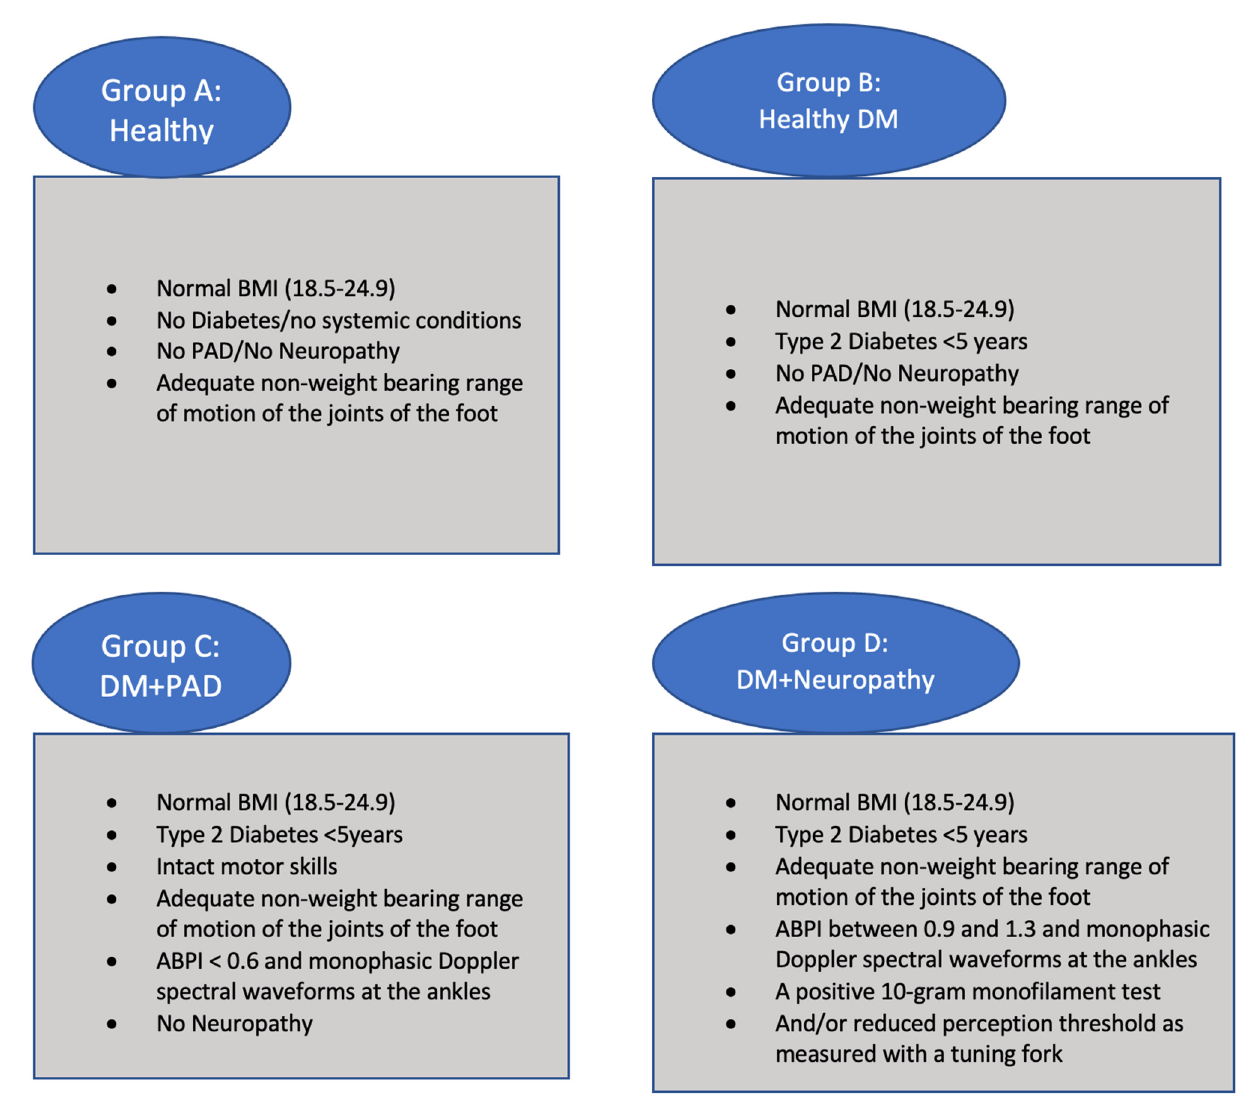
Figure 1. Inclusion criteria for each group. Twelve participants per group were recruited. Prior to data collection, demographics and medical history were recorded by a clinician (SP) in order to ensure that only those fitting the inclusion criteria were recruited.